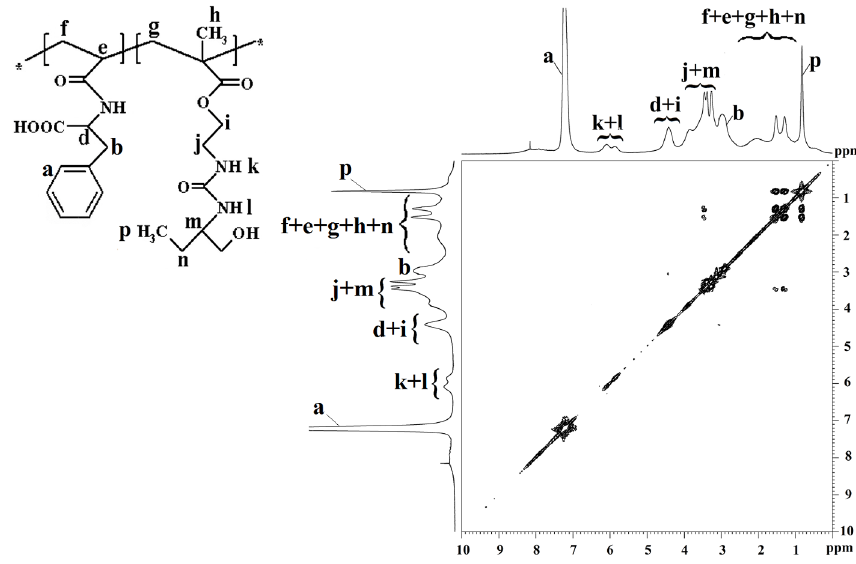
Figure 2. 1 H, 1 H-COSY spectrum of A-L-Phe- co -L-MABU copolymer, in DMSO- d